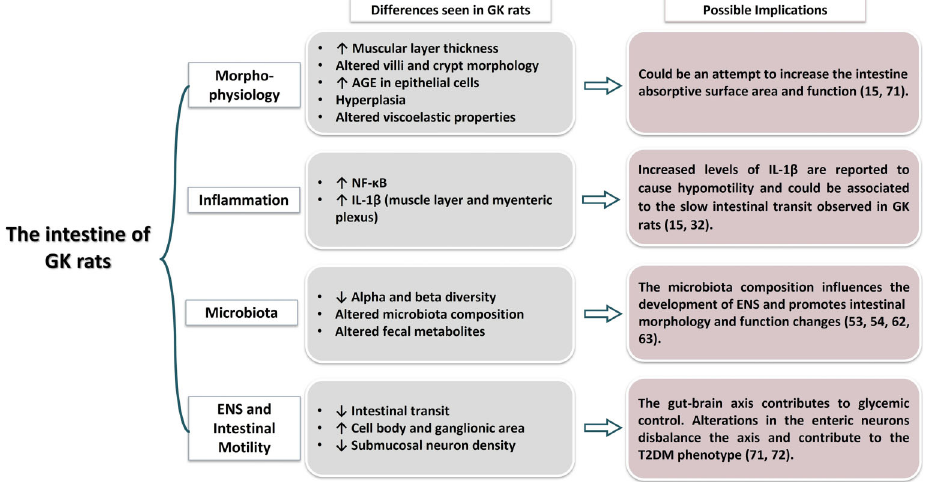
Figure 3. The pinpoint issues of the intestine of Goto-Kakizaki (GK) rats. ENS: enteric nervous system; GIT: gastrointestinal tract; AGE: advanced glycation